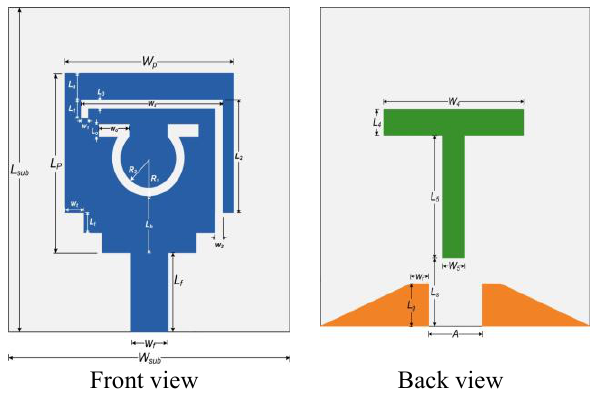
Figure1: Schematic diagram of the proposed antenna.